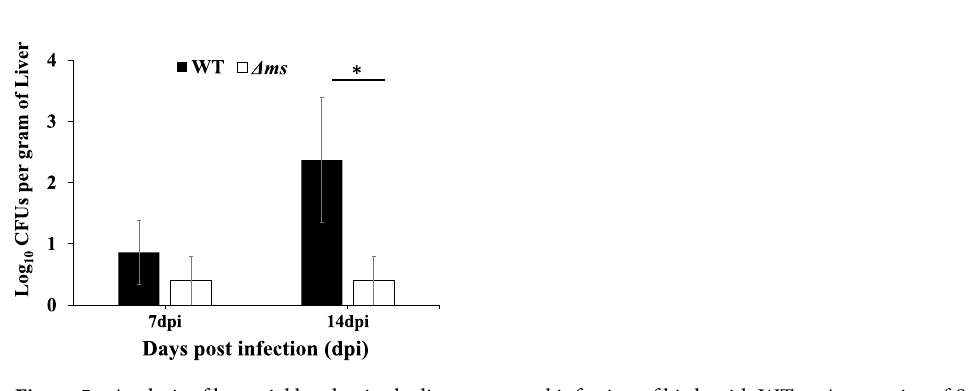
Figure 5. Analysis of bacterial burden in the liver upon oral infection of birds with WT or Δ ms strains of S. Typhimurium : the liver (100 mg) was homogenized in sterile PBS and 100 μl homogenate was plated on HEA plates. The CFU per gram of liver was calculated after 7 and 14 days post infection (dpi). The data are presented as mean ± SE (n = 5). * p <